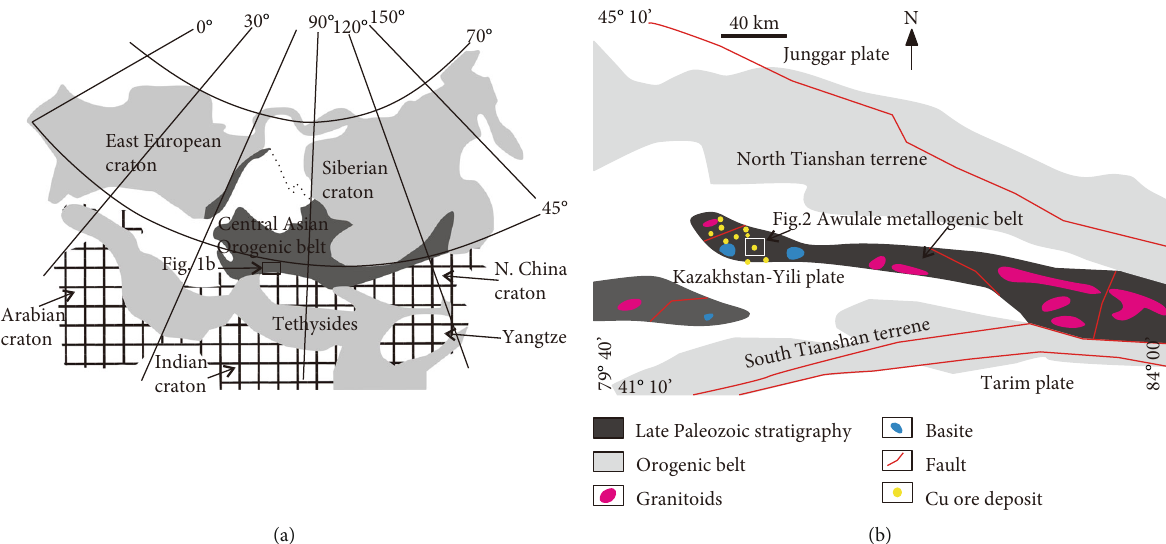
Figure 1: (a) Sketch map of the CAOB. (b) Sketch map of western Tianshan (modi fi ed from Zhang et al. [24]).